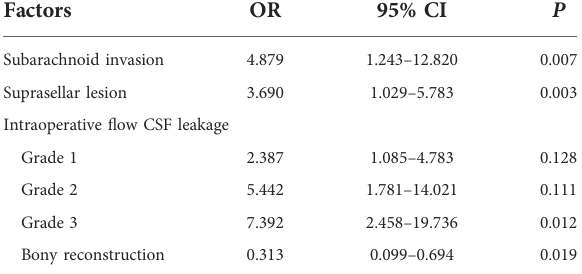
TABLE 4 Multivariate analysis for postoperative CSF leakage.